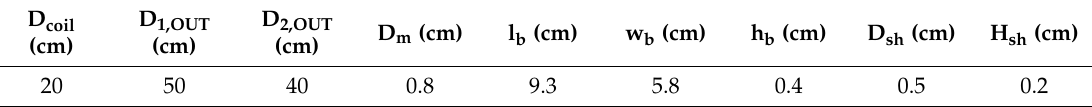
Table 1. Geometry parameters of the considered WPT system as shown in Figure